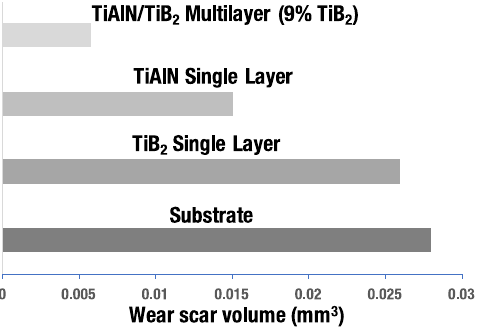
Figure 7. A comparison of wear ‐ scar volumes obtained from multi ‐ pass, bi ‐ directional wear trials conducted at a constant load of 10 N.